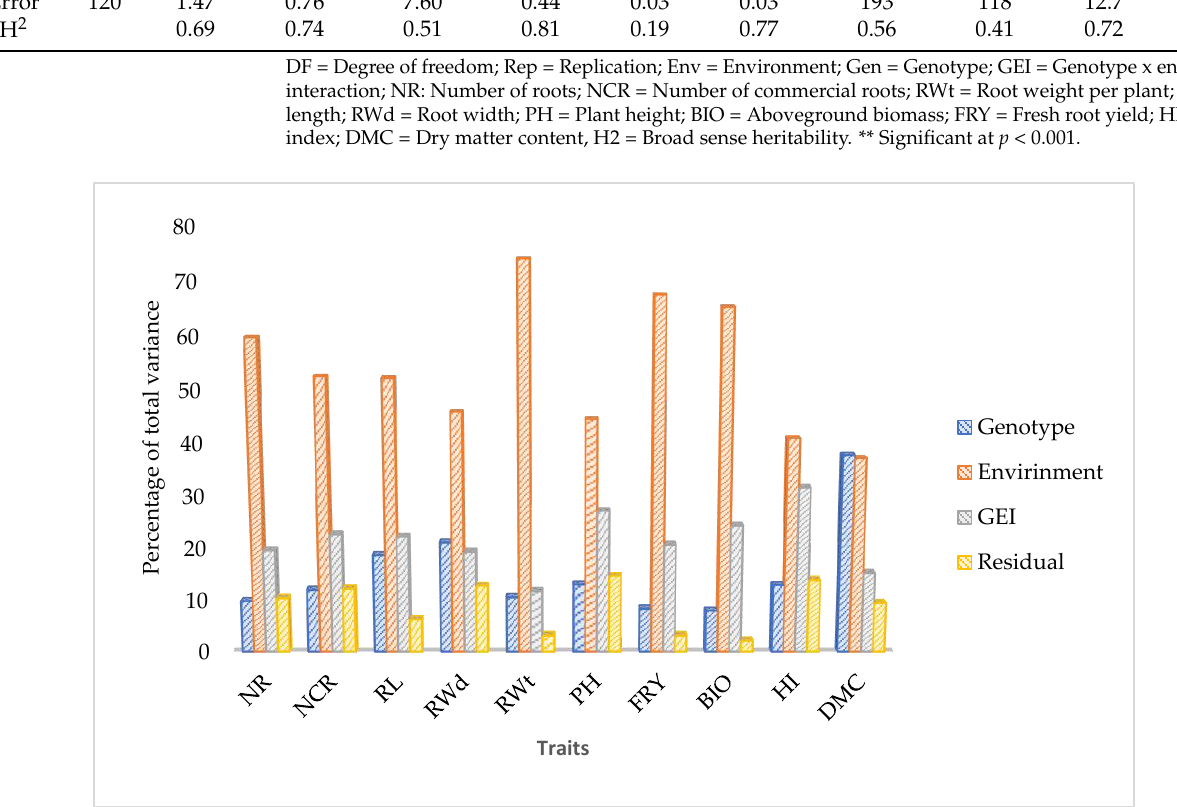
Figure 1. Partitioning of the total phenotypic variance into genotype, environment, GEI, and error variance. NR = Number of roots; NCR = Number of commercial roots; RWt = Root weight per plant; RL = Root length; RWd = Root width; PH = Plant height; BIO = Aboveground biomass; FRY = Fresh root yield; HI = Harvest index; DMC = Dry matter content.